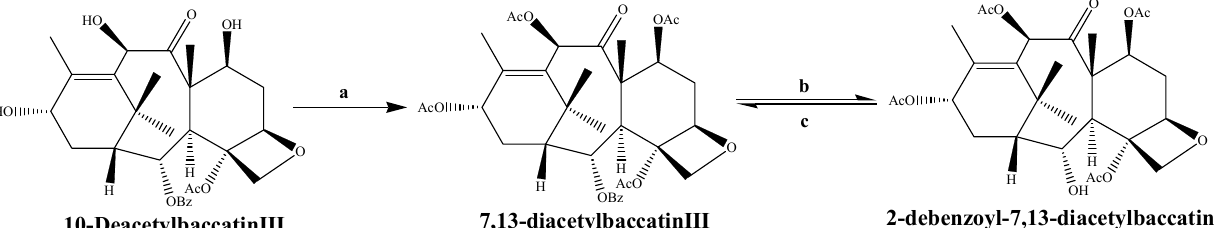
Figure 3. Outline of the synthesis and utilization of 2-debenzoyl-7,13-diacetylbaccatin III. Step a and step b indicate the synthetic pathway of 2-debenzoyl-7,13-diacetylbaccatin III from 10-deacetylbaccatin III. Step c indicates the reaction catalyzed by TBT in the presence of benzoyl-CoA.